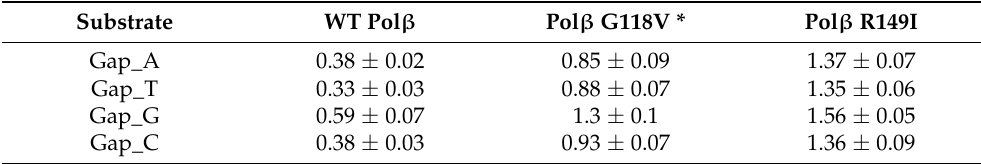
Table 2. Dissociation constants K d ( µ M) of the enzyme–DNA complex.